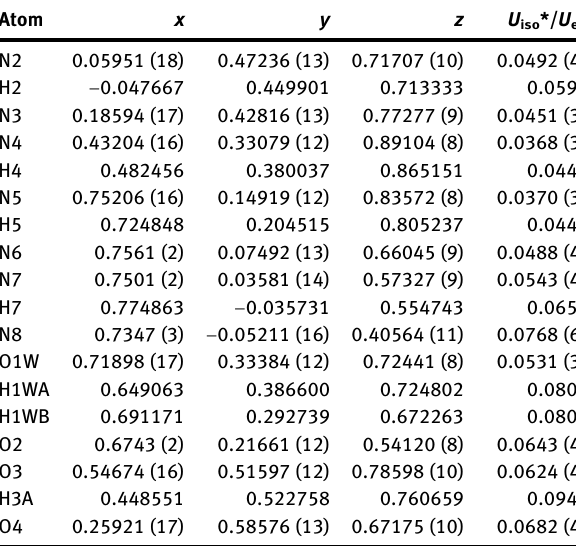
asymmetric unit consists of one target molecule, one MeOH molecule and one water molecule. The dihedral angle of two central pyridine rings is 78.73 ° . Through the hydrogen